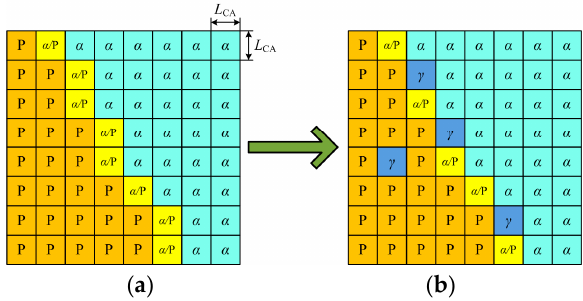
Figure 2. Schematic diagram of nucleation in cell lattice. ( a ) Before nucleation; ( b ) after nucleation. α represents ferrite, P represents pearlite, γ represents austenite and α /P represents ferrite–pearlite interface.